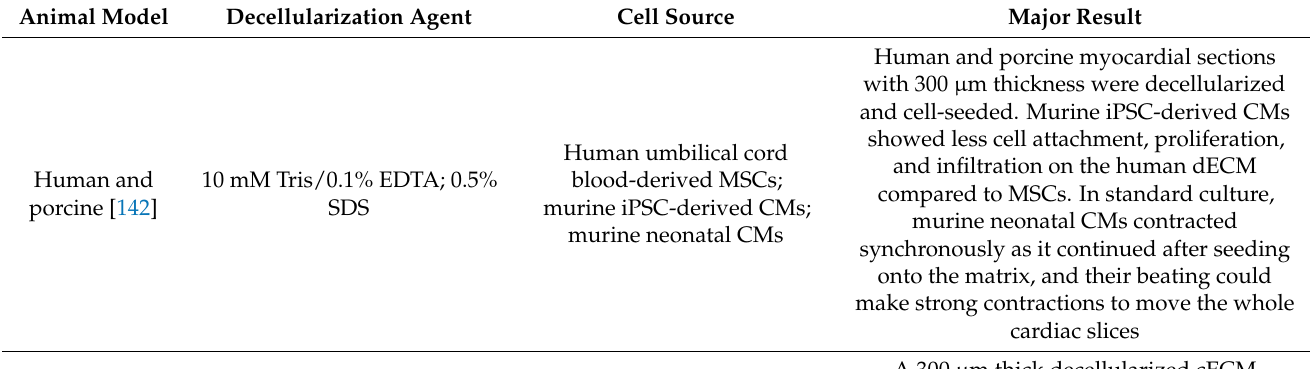
Table 6. Natural human myocardial ECM used for cardiac